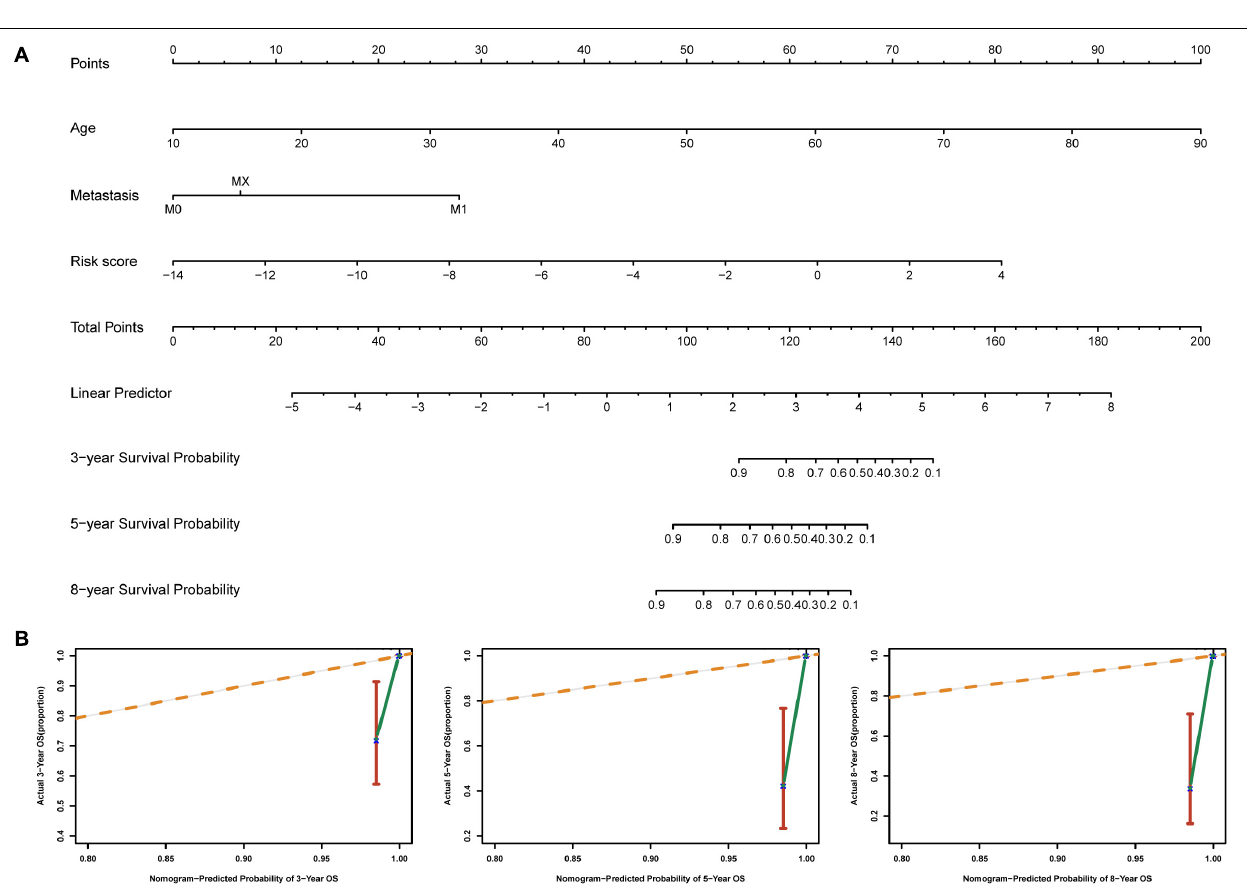
FIGURE 8 | Nomogram for predicting overall survival in THCA patients. (A) Construction of the nomogram was based on age, metastasis and risk score in the entire cohort. (B) The calibration plot for internal validation of the nomogram.